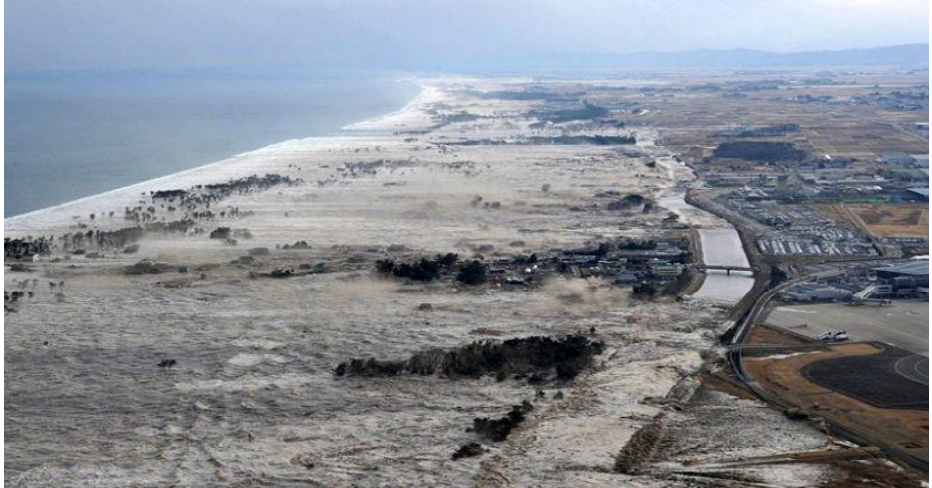
Figure 1. Image of tsunami propagating over a canal during the 2011 Japan Tsunami event Reprinted with permission from [5] (2022, ASCE).